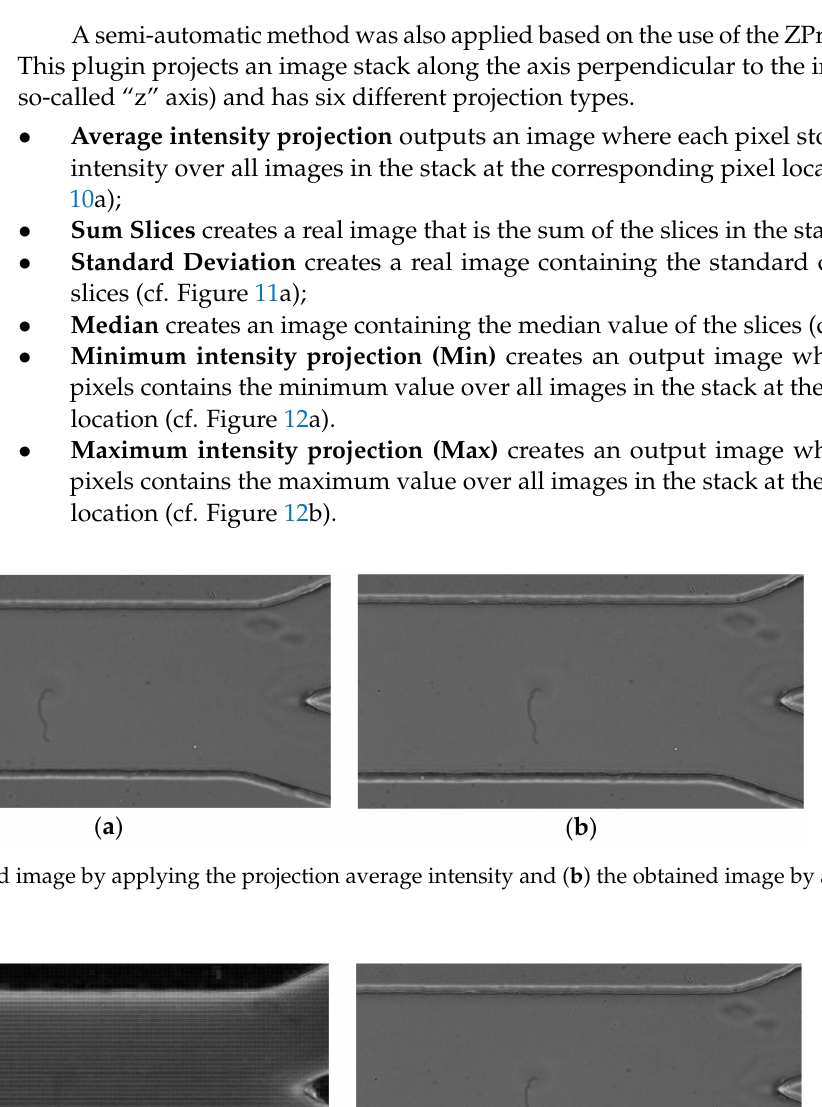
Figure 9. Manual method showing the trajectories of RBC defining the region of the CFL: ( a ) for an expansion geometry and ( b ) for a bifurcation geometry.